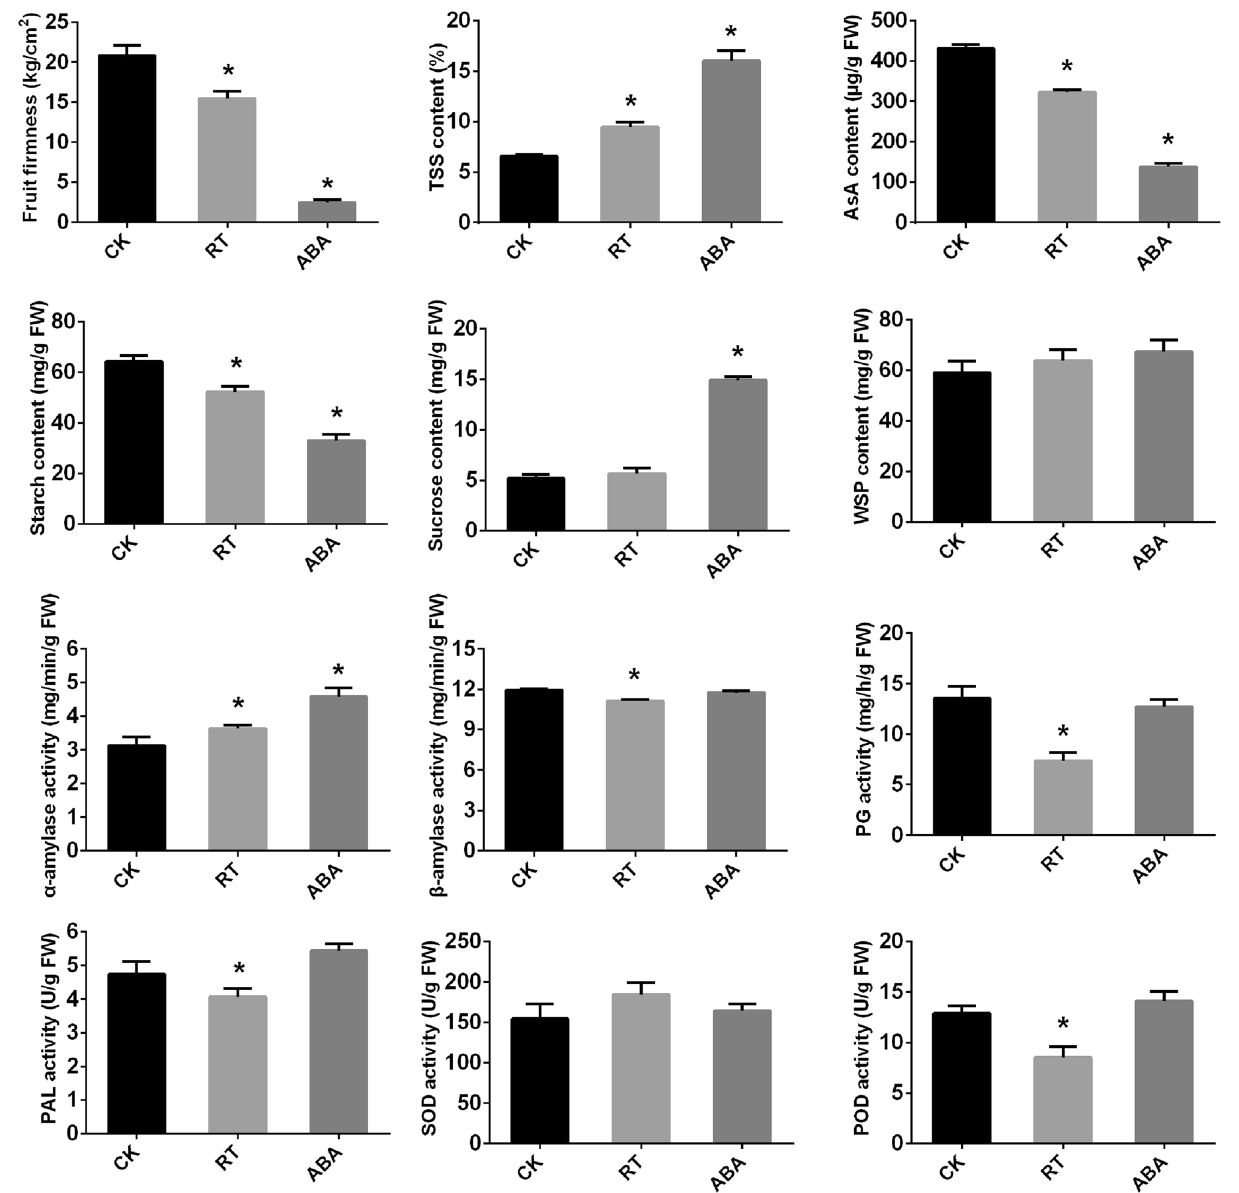
Figure 1. Physiological changes in kiwifruits under different treatments. AsA, ascorbic acid; FW, fresh weight; PAL, phenylalnine ammonialyase; PG, polygalacturonase; POD, peroxidase; SOD, superoxide dismutase; TSS, total soluble solid; WPS, water soluble pectin. CK, freshly harvested fruits (fruit maturity stage); RT, fruits stored at 25 °C for 7 days (postharvest ripening stage); ABA, fruits treated with 50 mg/L ABA for 2 min and then stored at 25 °C for 7 days (softening stage). One-way analysis of variance (ANOVA) in the SPSS software was used for statistical analysis. The asterisk indicates significant differences ( P < group. The superoxide dismutase (SOD) activity showed a slight increase in both RT and ABA groups without any obvious differences. High-throughput sequencing and genome-wide identification of lncRNA in kiwifruit. A total of 288,869,672 raw sequence reads were obtained from CK, RT, and ABA-treated samples using strand-specific RNA-seq to investigate the underlying changes in genes and lncRNAs during kiwifruit ripening and softening. More than 96% of raw reads were clean reads. Of these clean reads, 68.68%, 70.85%, and 62.39% were mapped reads in the ABA, RT, and CK groups, respectively, and 66.20%, 68.45%, and 59.63% were unique mapped reads (Table S1). After matching with the kiwifruit reference genome, 28,976 known mRNAs, 12,388 novel mRNAs, and 27,402 lncRNAs were identified. Further, 27,402 lncRNAs were classified into three types (lincRNAs, intronic lncRNAs, and antisense lncR- NAs) based on their genomic positions and orientations relative to adjacent protein-coding genes. A majority